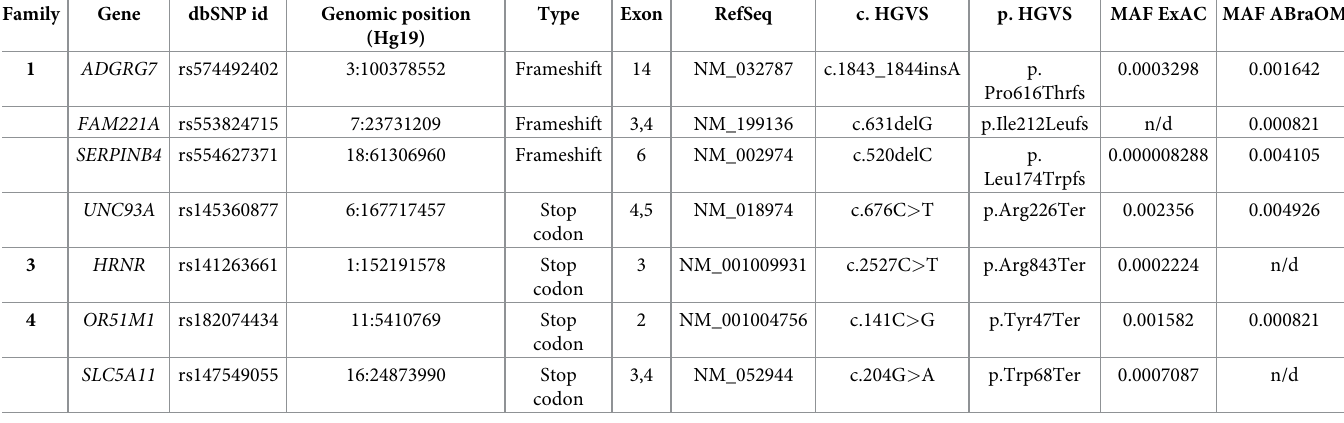
Table 4. Rare germline LoF variants identified by WES in the 5 melanoma-prone